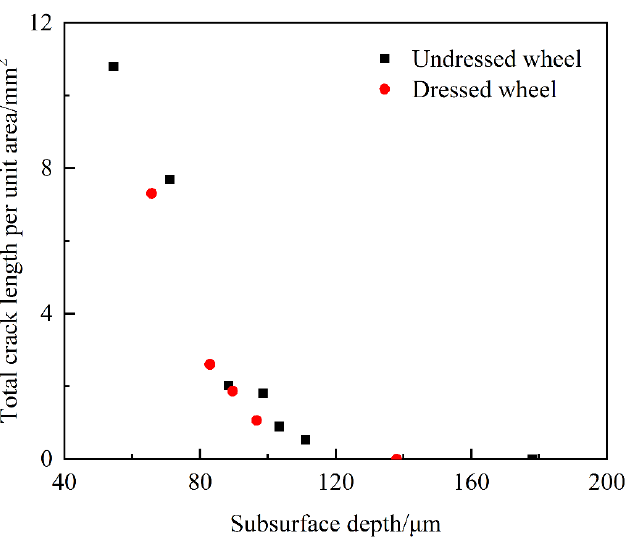
Figure 14. Results of the variation in total crack length per unit area with depth under different grinding wheels.